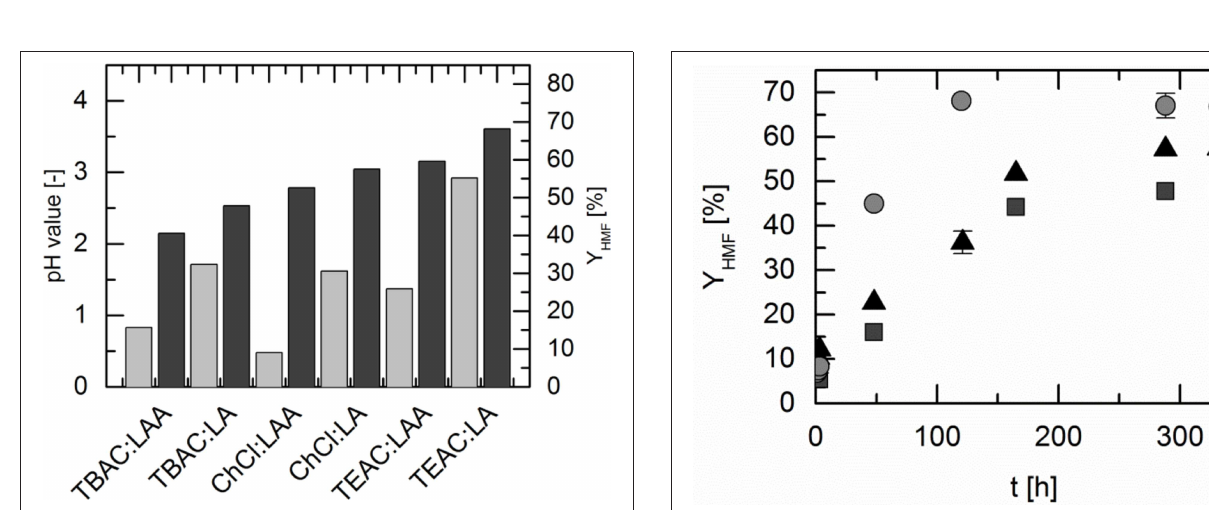
FIGURE 4 | 5-Hydroxymethylfurfural (HMF) yield over time in the different deep eutectic systems based on levulinic acid (LA); reaction temperature 323K; w FRU,0 = 2.5 wt.%; pressure 1 bar. Symbols are yields in different DESs: triangles: choline chloride (ChCl):LA 1:2; squares: tetrabutyl